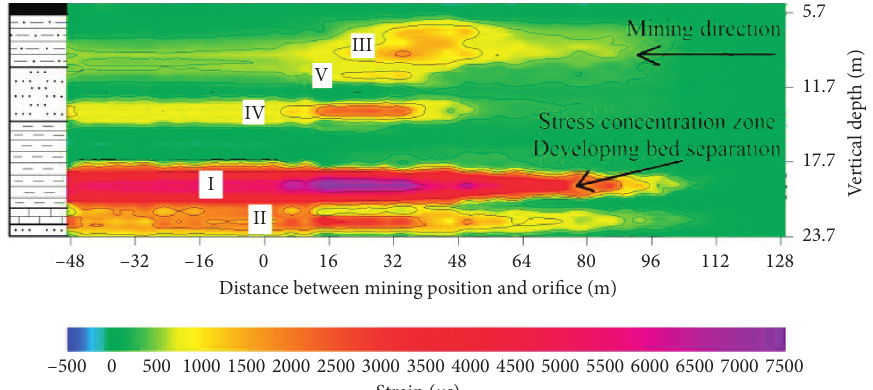
Figure 7: Fiber optic strain distribution nephogram during the monitoring